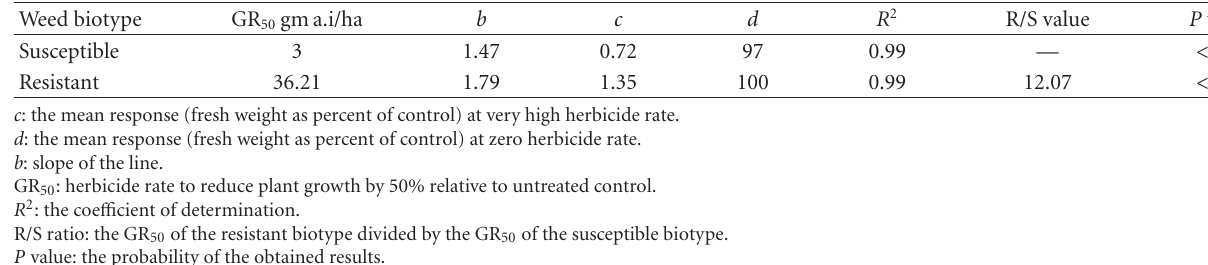
Table 1: E ff ect of fenoxaprop-p-ethyl on the susceptible and resistant biotypes of E. crus-galli expressed as the rates of the herbicide required for 50% reduction of the aboveground biomass (GR 50 ) and estimated resistance ratio.